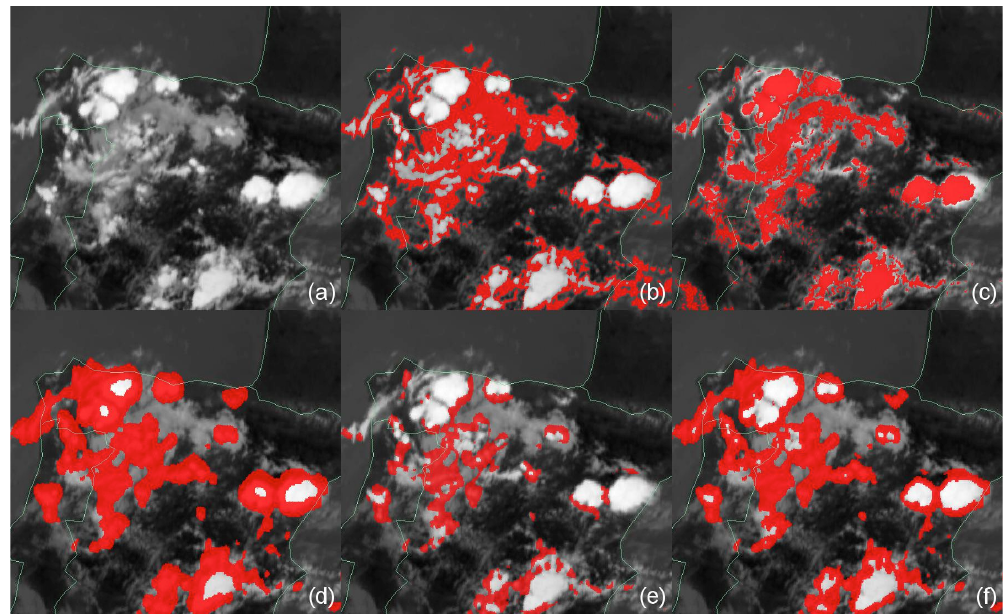
Fig. 1. Limitation to IF: (a) IR10.8 cloud scene over Iberian Peninsula with various (convective) cloud types. Different tests for the convective cloud IF masks: (b) 253K < IR10.8 < 278K, (c) HRV > 0.5, (d) local standard deviation at WV7.3 and IR10.8, (e) IF mask at daytime, (f) and nighttime condition (without HRV). Positive test results for each pixel are plotted in